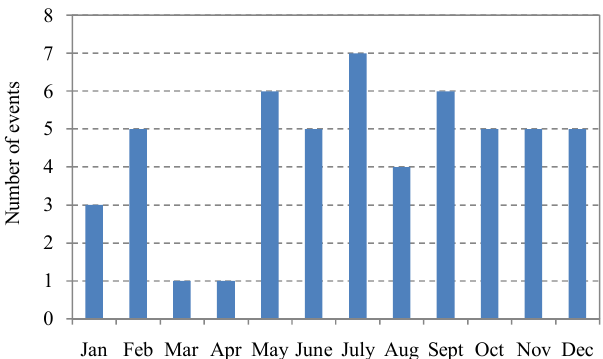
Fig. 6. Number of fatalities from lightning strikes, for the period 2001–2011.